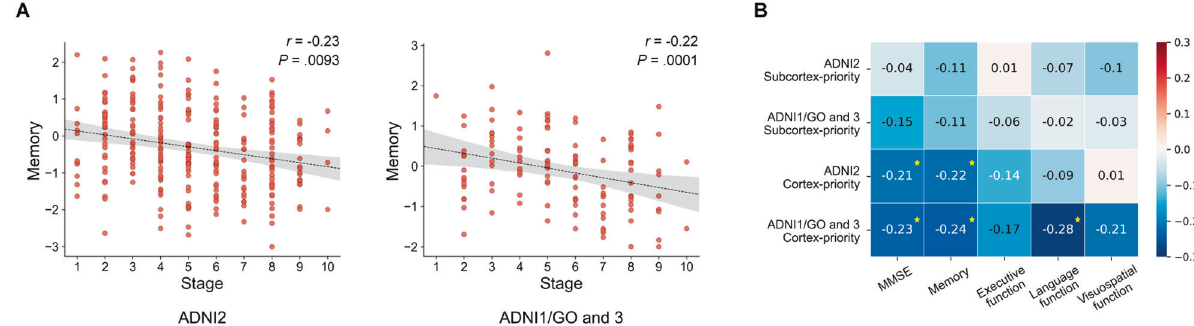
Fig. 4 Subtypes exhibit distinct clinical pro fi les. A Progression stages of the cortex-priority subtype were associated with memory decline across the two datasets. B Characterization of the relationship between the progression stages of the subcortex-priority and cortex-priority subtypes and the clinical pro fi les. All associations were tested by Spearman correlation while controlling covariates (age, gender, and education). Values in white indicate P values below .05 and stars indicsate P values below